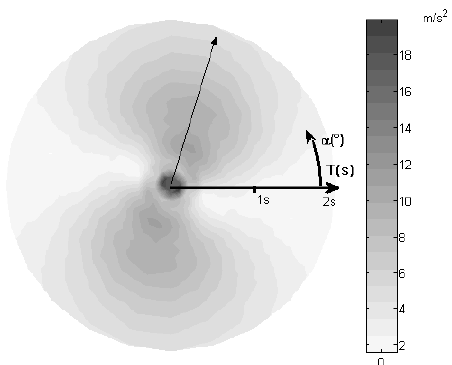
Figure 8. Polar Spectrum in terms of pseudo-acceleration for the South Iceland aftershock (code 006334).